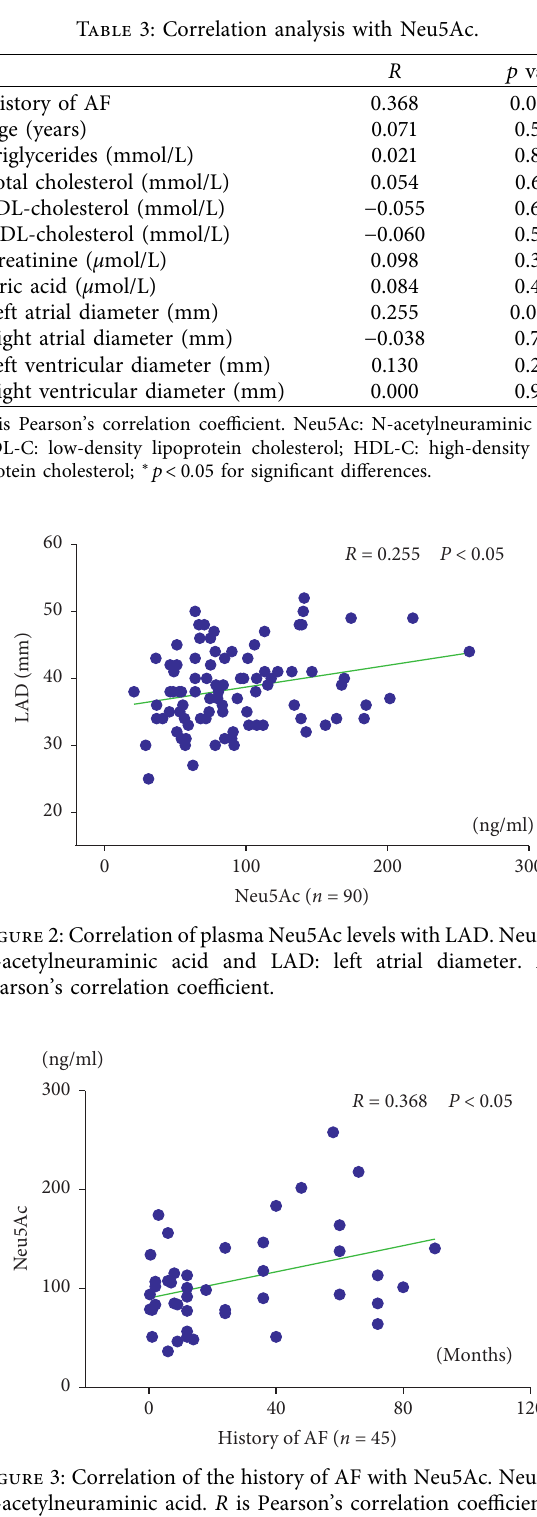
Figure 3: Correlation of the history of AF with Neu5Ac. Neu5Ac: N-acetylneuraminic acid. R is Pearson’s correlation coefficient.